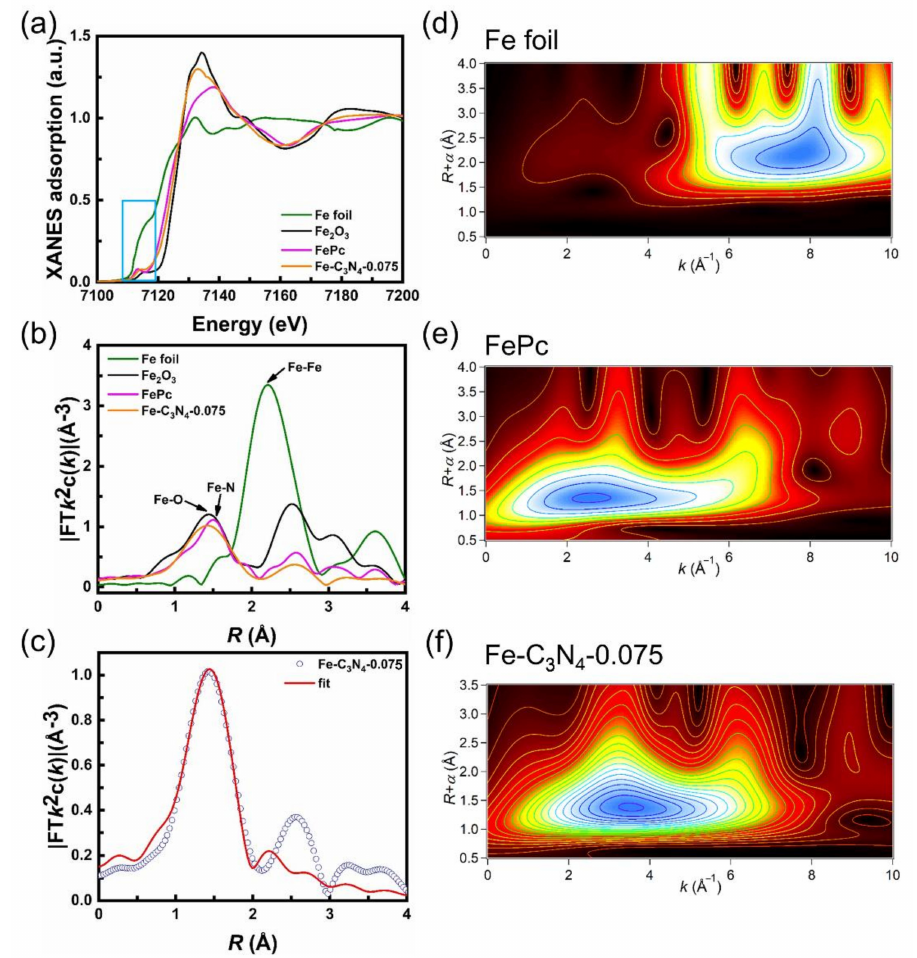
Figure 5. ( a ) XANES spectra (the orange area highlights the near-edge absorption energy). ( b ) Fourier transform (FT) of the Fe K-edge. ( c ) The corresponding EXAFS r space fitting curves of Fe-C 3 N 4 -0.075. Wavelet transform (WT) of Fe K-edge for ( d ) Fe foil, ( e ) FePc and ( f ) Fe-C 3 N 4